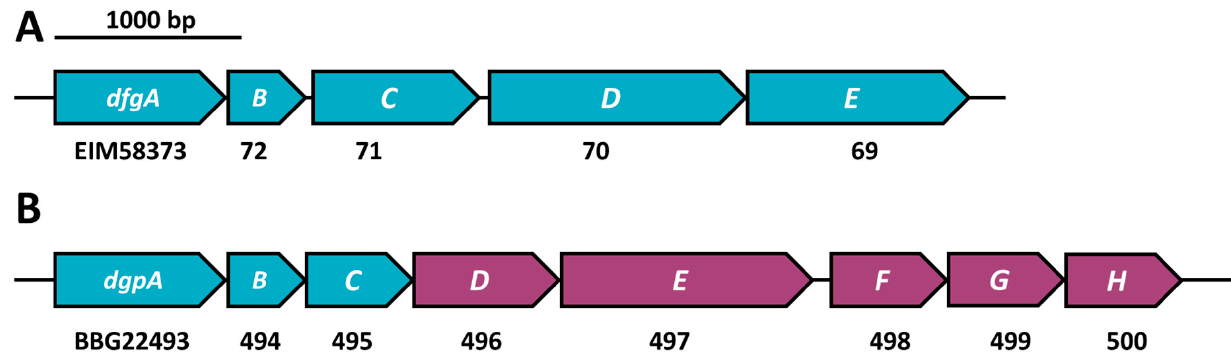
Figure 3. Two characterized C -deglycosylation gene clusters. ( A ) Eubacterium cellulosolvens with five genes involved in C -deglycosylation [17] and ( B ) strain PUE [25,26], with dgpA encoding an oxidoreductase and dgpBC as oxo-puerarin-deglycosylating enzymes, of which all three are involved in C -deglycosylation. Genes encoding deglycosylating enzymes are shown in turquoise, accessory genes in violet. The full GenBank accession number is given for the first gene and only variable digits are given for the downstream genes.